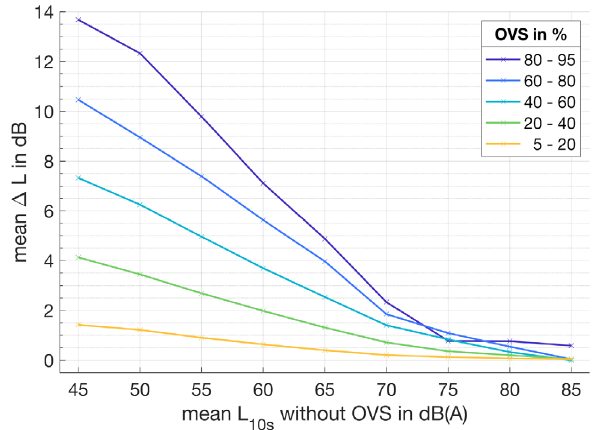
Figure 9. OVS-Exclusion: Mean difference in the A weighted SPL D L due to OVS exclusion, calculated for 10 s-intervals with 50% overlap for all participants and recording days. The contours depend on the background SPL ( L 10s without OVS) and on the predicted proportion of